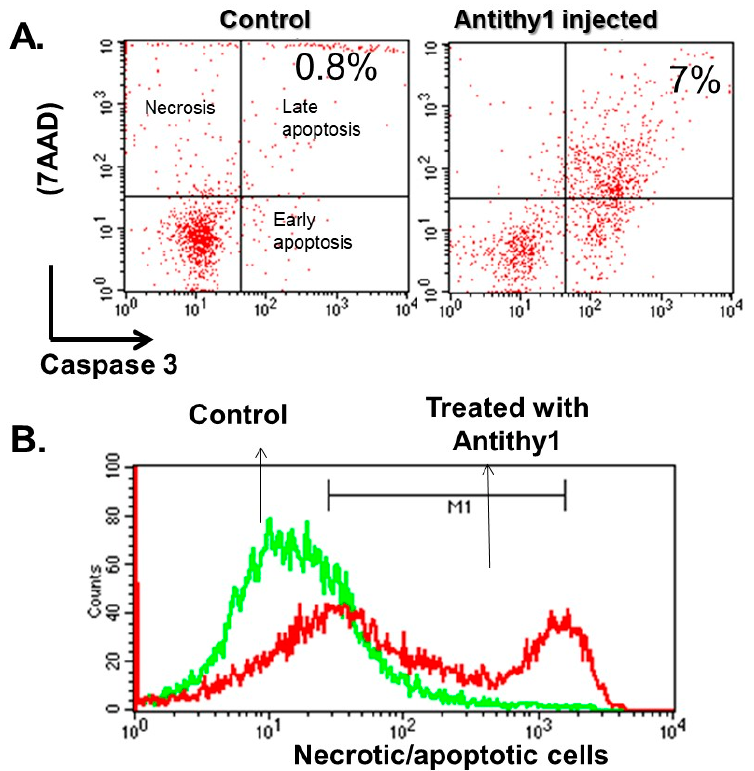
Figure 1. Assessment of apoptosis (caspase 3) and necrosis (7-AAD) in glomeruli isolated from control and anti-Thy1-injected rats (1 mg/kg i.v.). Representative of flow cytometry analysis of apoptosis (caspase 3) and necrosis (7-AAD) in two-dimensional dot plot ( A ) and in histogram ( B ) in a comparative mode based on counted total cells. Injection of anti-Thy1 produced 9-fold increase in glomerular apoptosis vs. control.